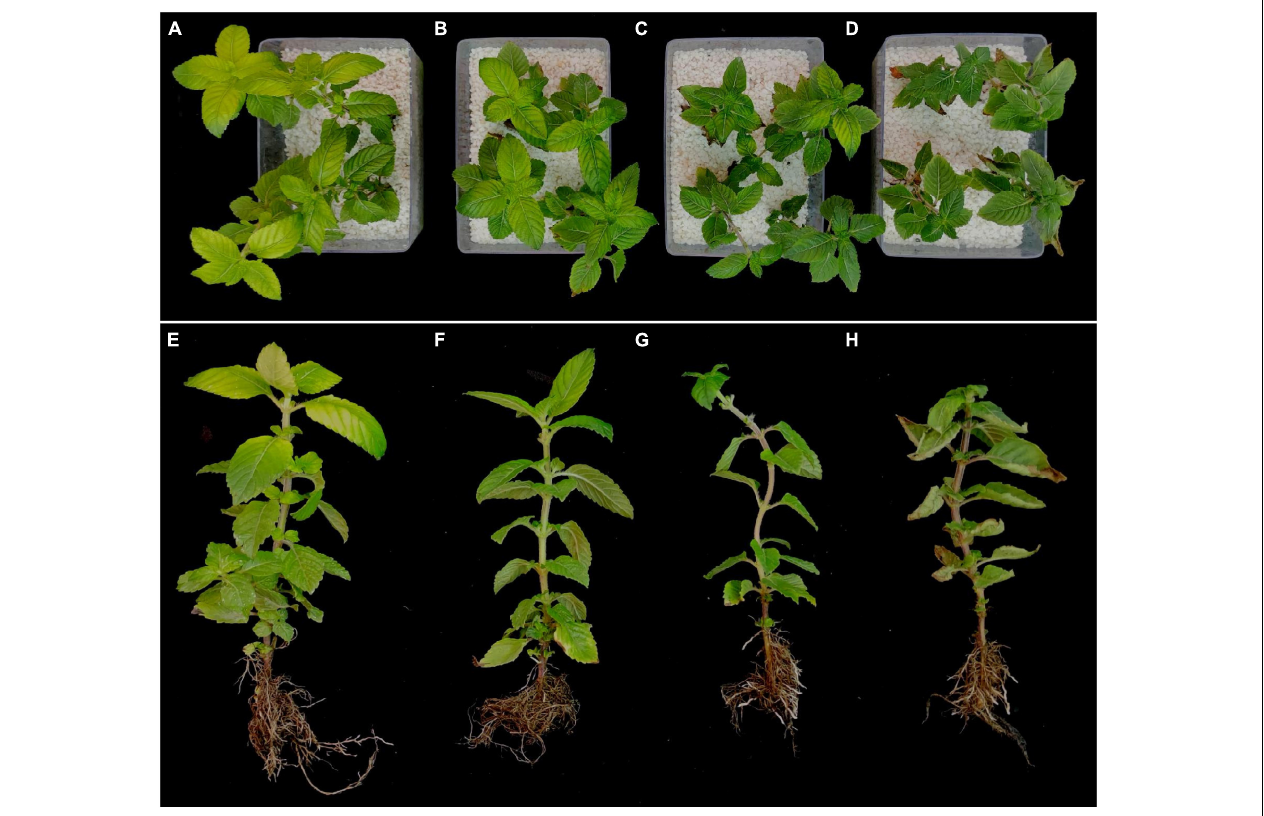
FIGURE 1 | Phenotypic changes of Mesona Chinensis Benth (MCB) under normal (CK) and drought stress conditions. (A,E) The plants under normal condition. (B,F) The plants under 5% PEG6000 condition. (C,G) The plants under 10% PEG6000 condition. (D,H) The plants under 15% PEG6000 condition.